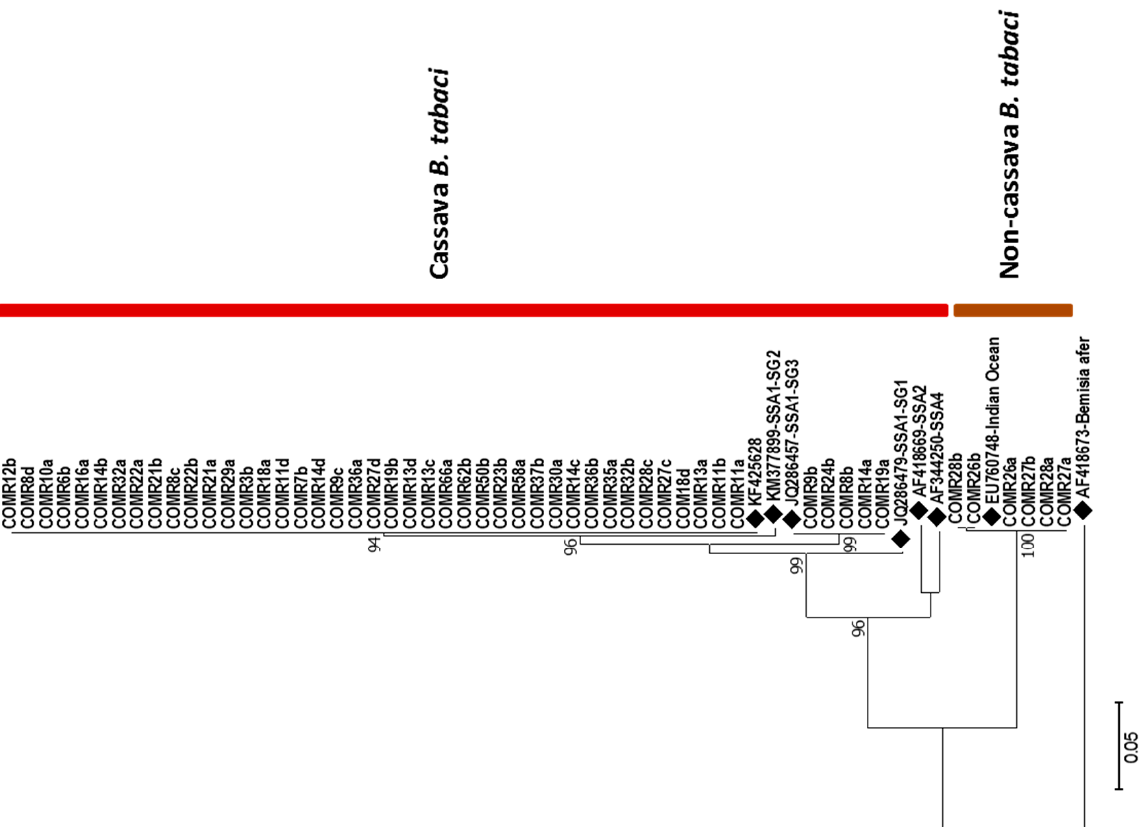
Figure 3. Maximum likelihood phylogenetic tree constructed for COI sequences obtained from Bemisia tabaci collected from Comoros Islands in July 2019. Reference sequences from GenBank ( (cid:7) ) are included for comparison. Bemisia afer , AF418673, was included as an outgroup. The numbers at the nodes represent bootstrap